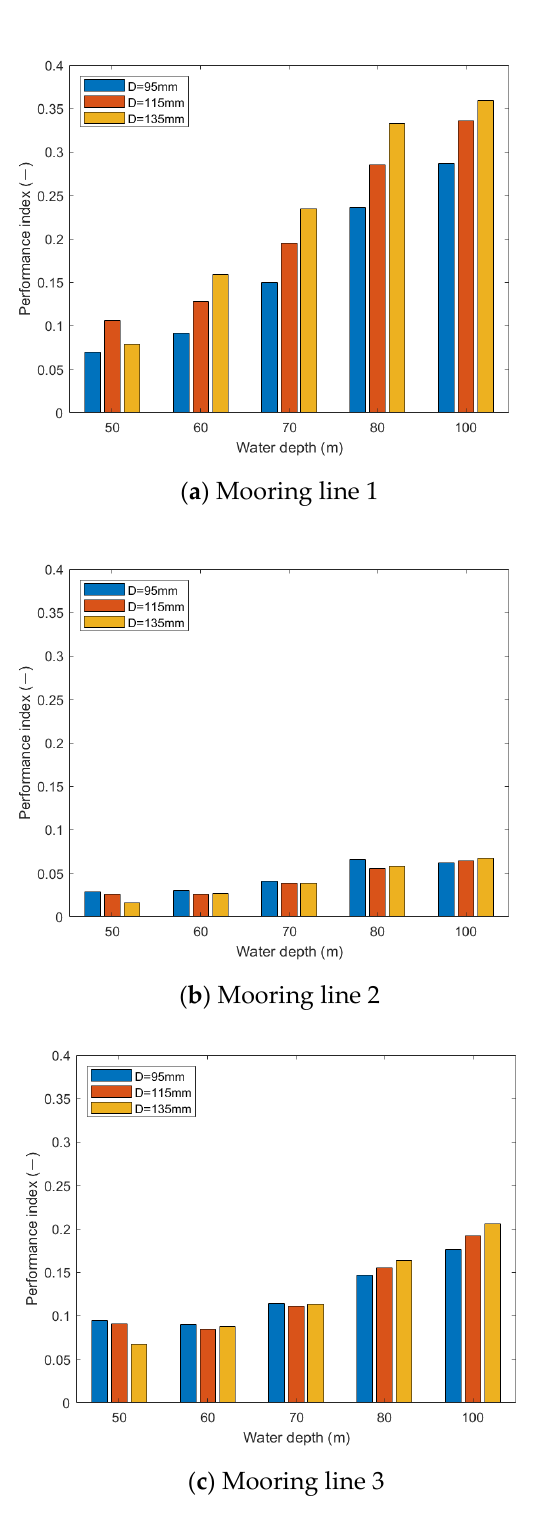
Figure 11. Performance index value of each mooring line for the different water depths. Table 9. The final mooring system design for the studied water depth (unit: D (mm), L (m)).